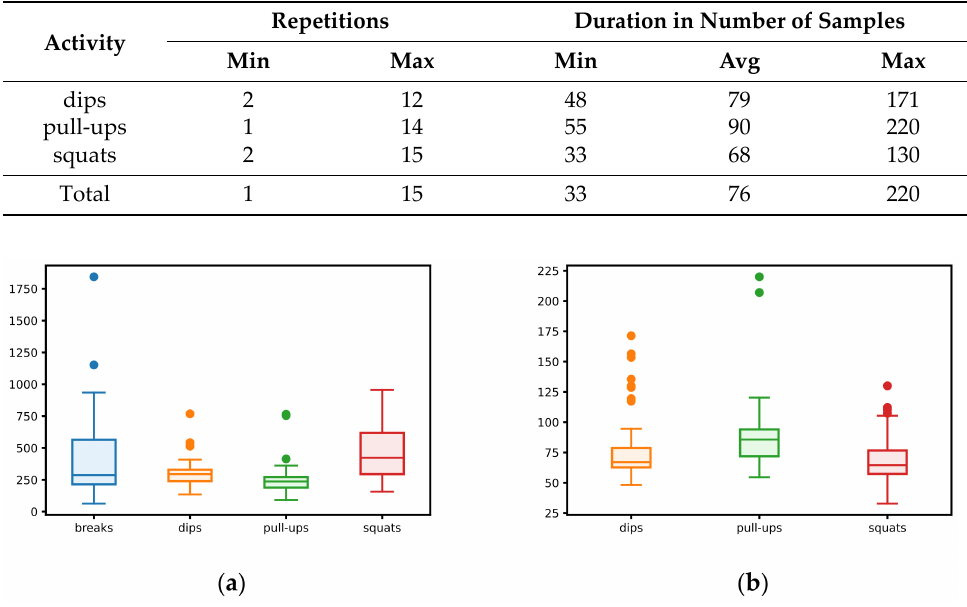
Figure 3. ( a ) Distribution of total time; ( b ) distribution of time per repetition of a given